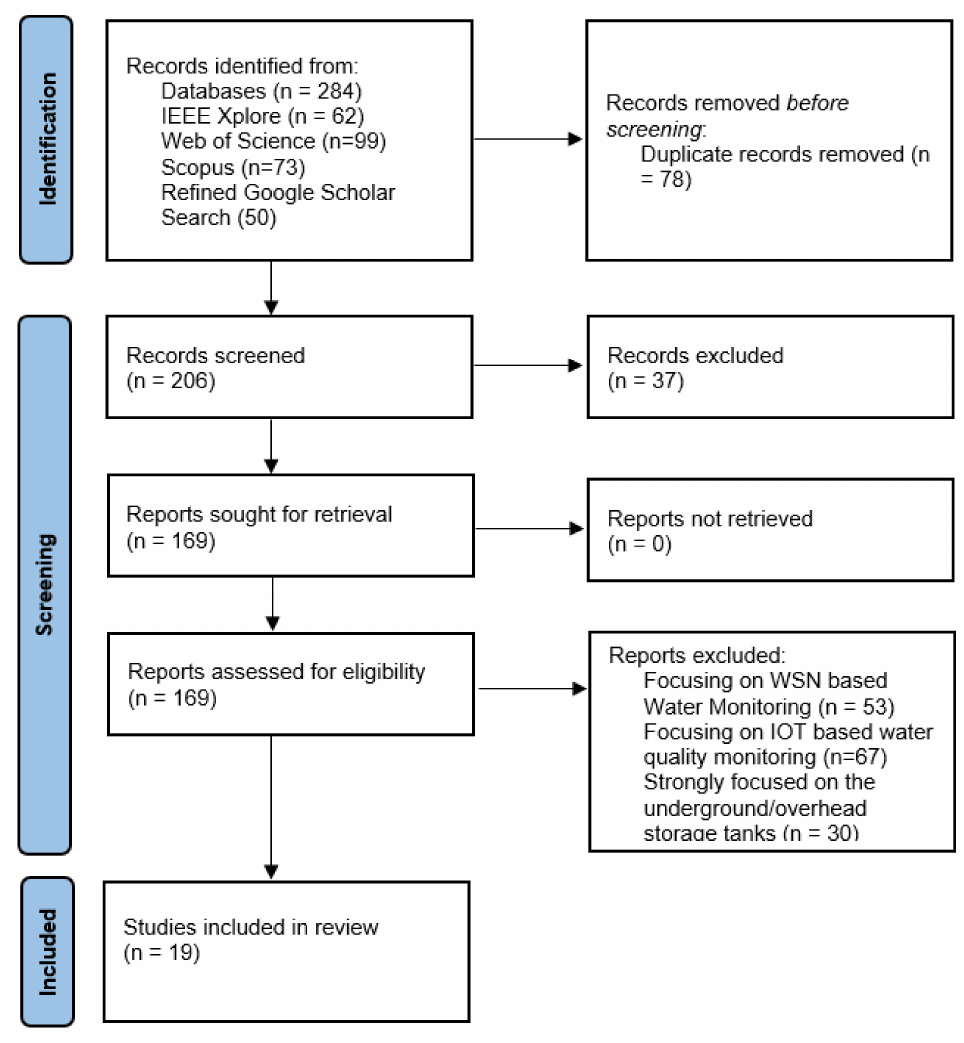
Figure 3. Workflow of the systematic literature review